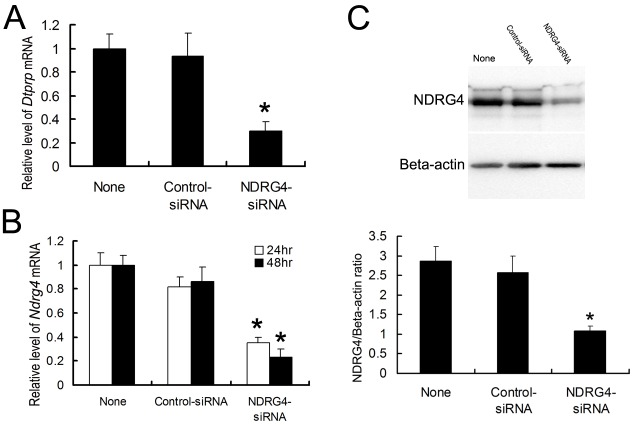
Down-regulation of NDRG4 expression in ESCs inhibits in vitro decidualization.Quantitative PCR analyses of DTPRP mRNA expression (A) and NDRG4 mRNA expression (B) in ESCs transfected with NDRG4-targeting siRNAs or non-targeting siRNAs at 24 h and 48 h. Western blot and densitometric analyses of NDRG4 protein levels in ESCs at 72 h after transfection (C). The relative fold induction of NDRG4 protein expression compared with its expression in non-siRNA-treated group is shown. The values represent the mean ± SEM, as determined from three separate experiments. *, significantly different (P < 0.05).